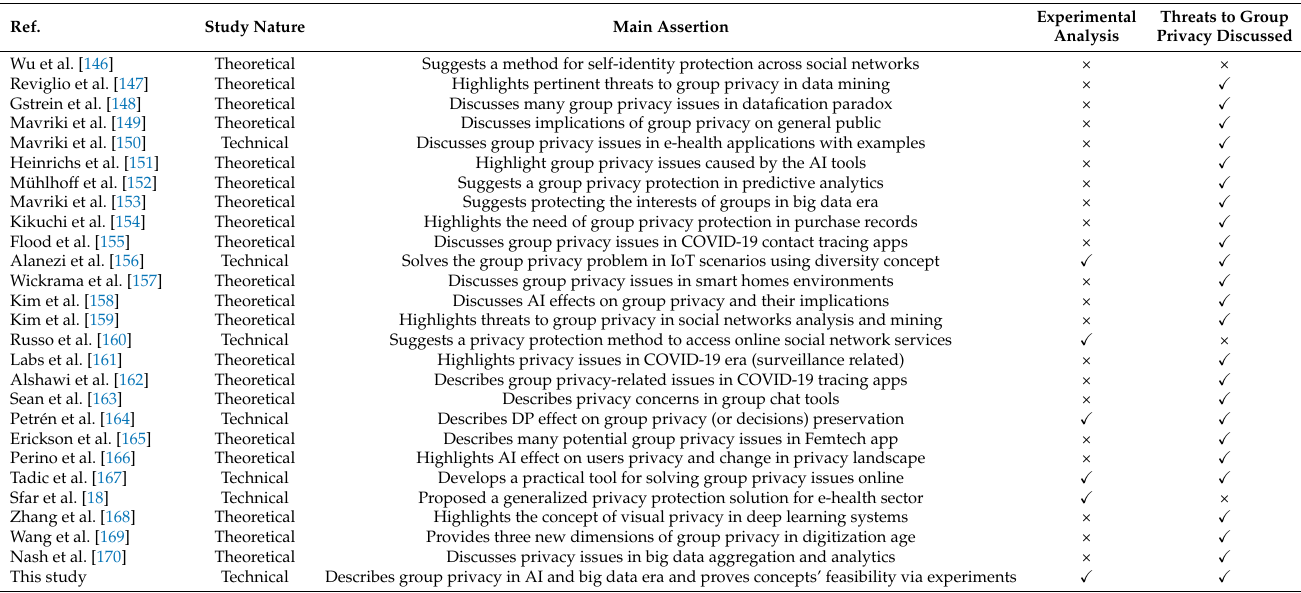
Table 1. Summary and comparison of group privacy protection